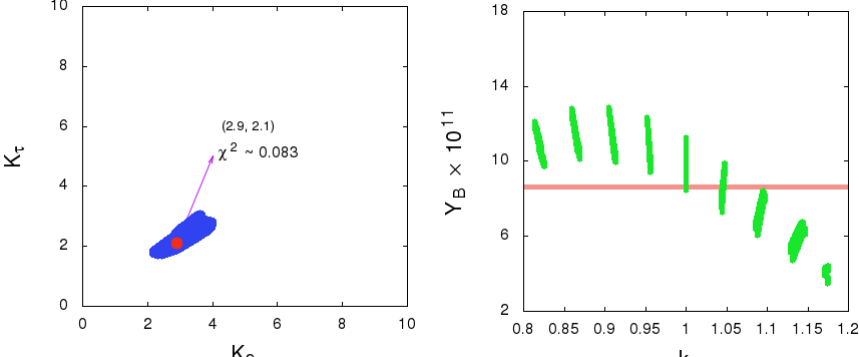
Figure 6 . The plot on the left hand side shows the range of the wash-out parameters. The red dot corresponds to the minimum value of (cid:31) 2 for which a set of primed parameters has been taken to compute Y B . The plot on the right hand side shows a variation of Y B vs k . The red band in the same plot indicates the observed range of Y B .